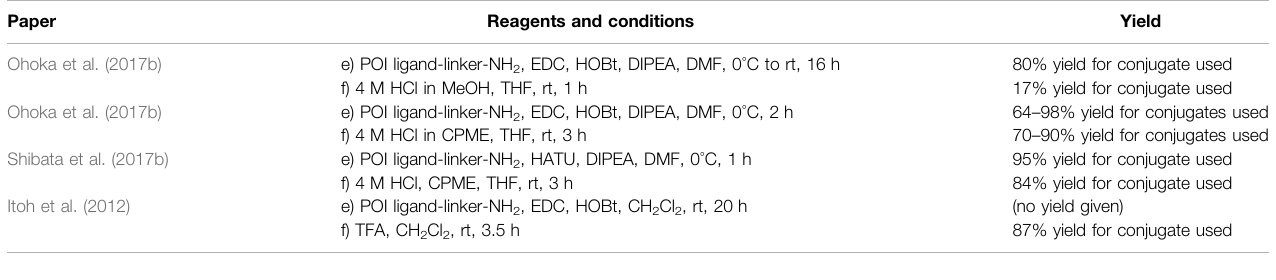
TABLE 7 | Reagents, conditions, and yields for the conversion of 207 to 209 ( Scheme 35 , steps e – f).